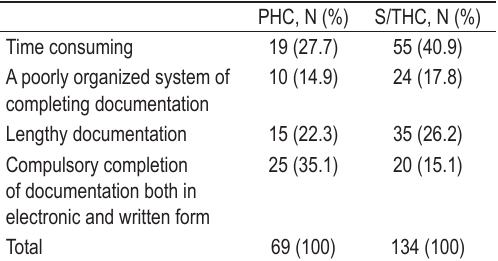
TABLE 4 . Disadvantages of submitted nursing documentation